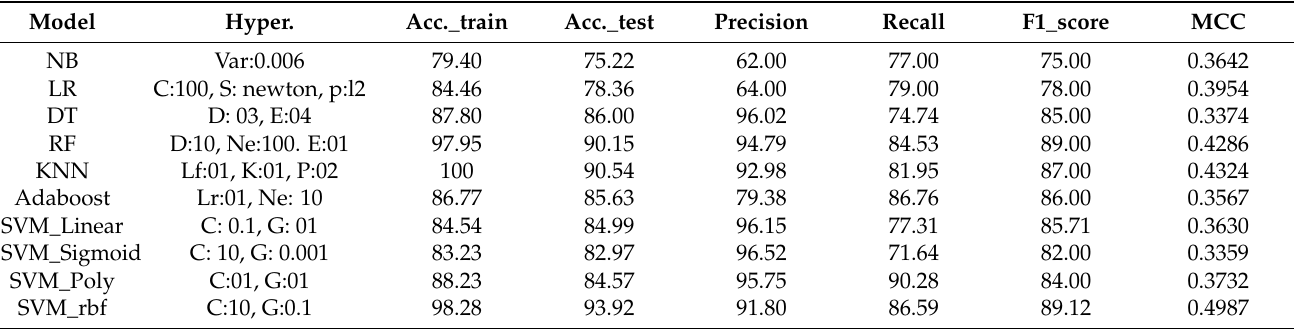
Table 5. Performance of ML models on balance data using